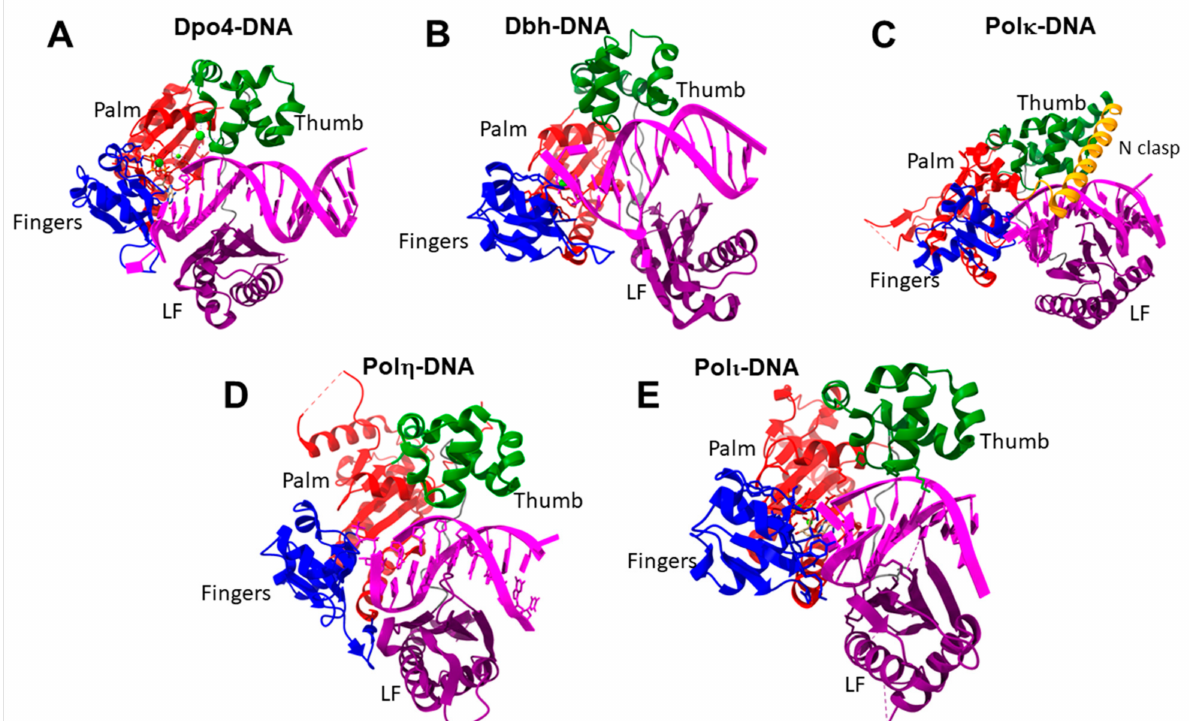
Figure 8. Three-dimensional structure of the complex of ( A ) Dpo4 (PDB ID 2agp), ( B ) Dbh (PDB ID 3bq1), ( C ) Pol κ (PDB ID 3pzp), ( D ) Pol η (PDB ID 4ed8), and ( E ) Pol ι (PDB ID 3gv8) with DNA. The thumb (green), palm (red), and fingers (blue) domains are presented; for Pol κ , the unique N-clasp domain at the N-terminus is presented